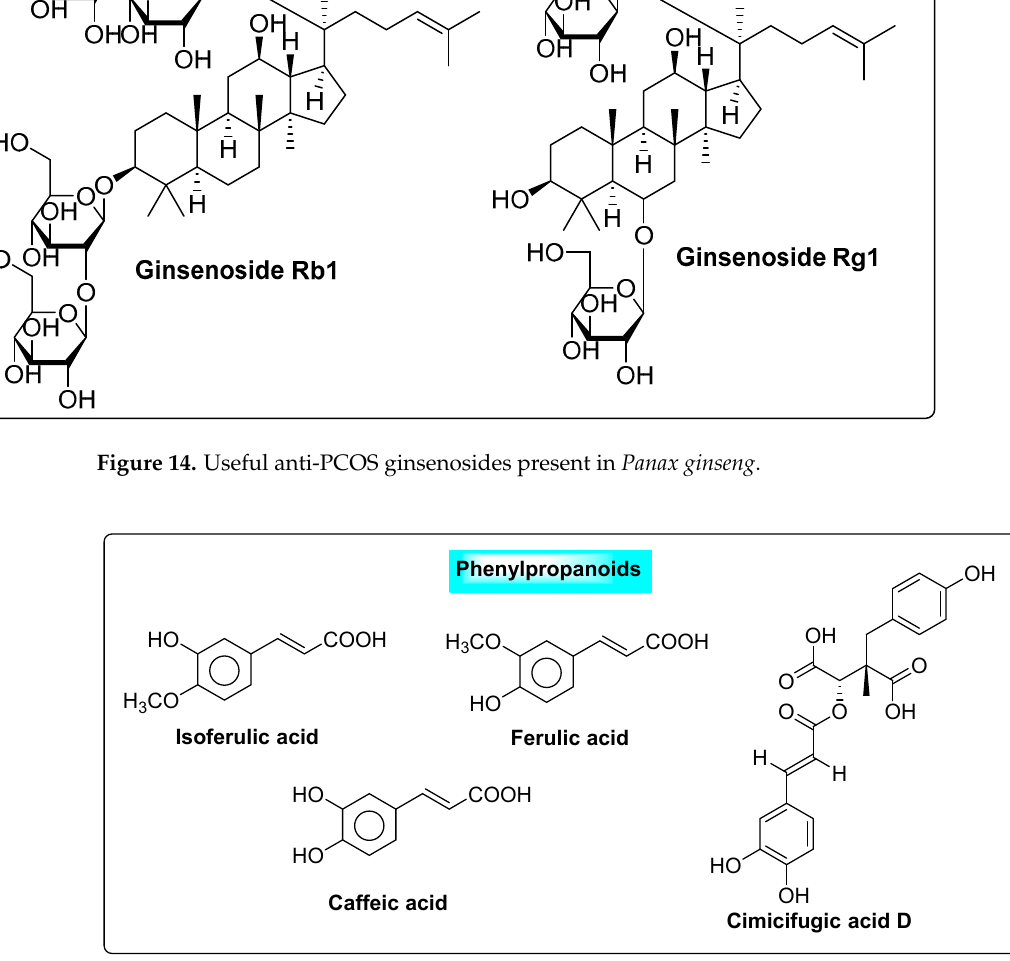
Figure 14. Useful anti-PCOS ginsenosides present in Panax ginseng .